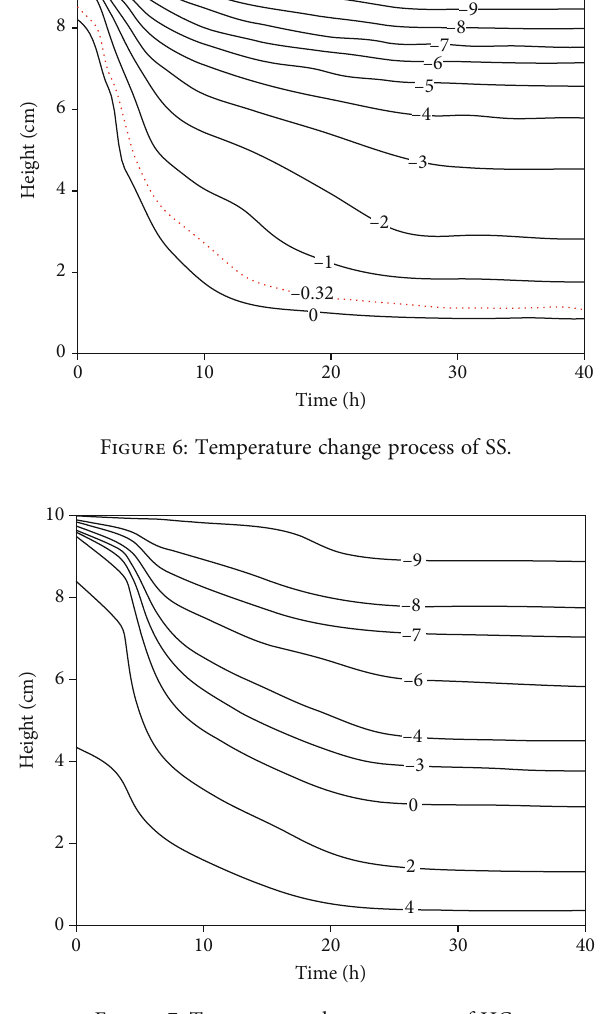
Figure 7: Temperature change process of